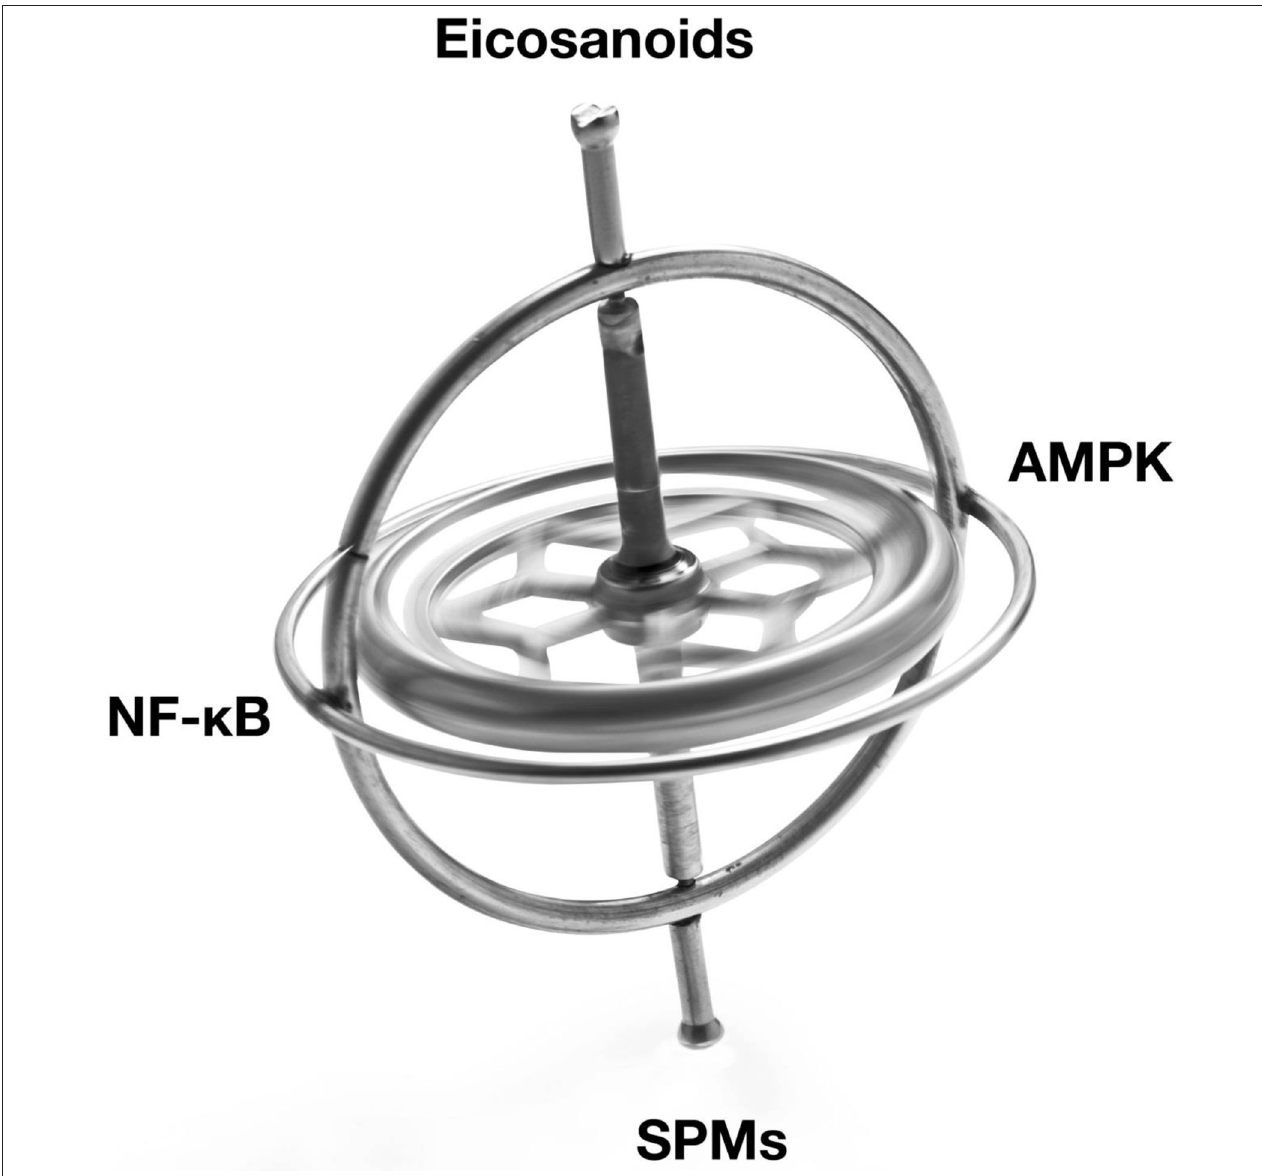
FIGURE 1 | Illustration of the balancing of the signaling agents involved in the Resolution Response. AMPK, 5’ adenosine monophosphate-activated protein kinase; NF- κ B, Nuclear factor kappa-B; SPMs, Specialized pro-resolving meditators.